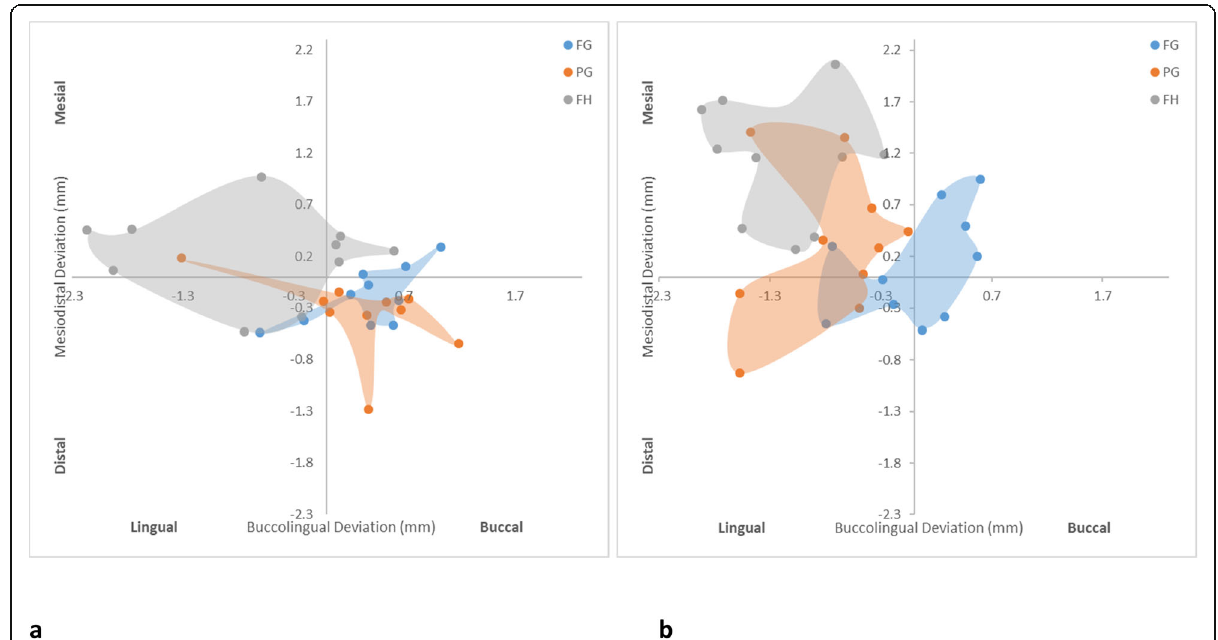
Fig. 7 Scatter diagrams illustrating the distribution of horizontal neck deviation of each protocol. a Anterior implants. b Posterior implants